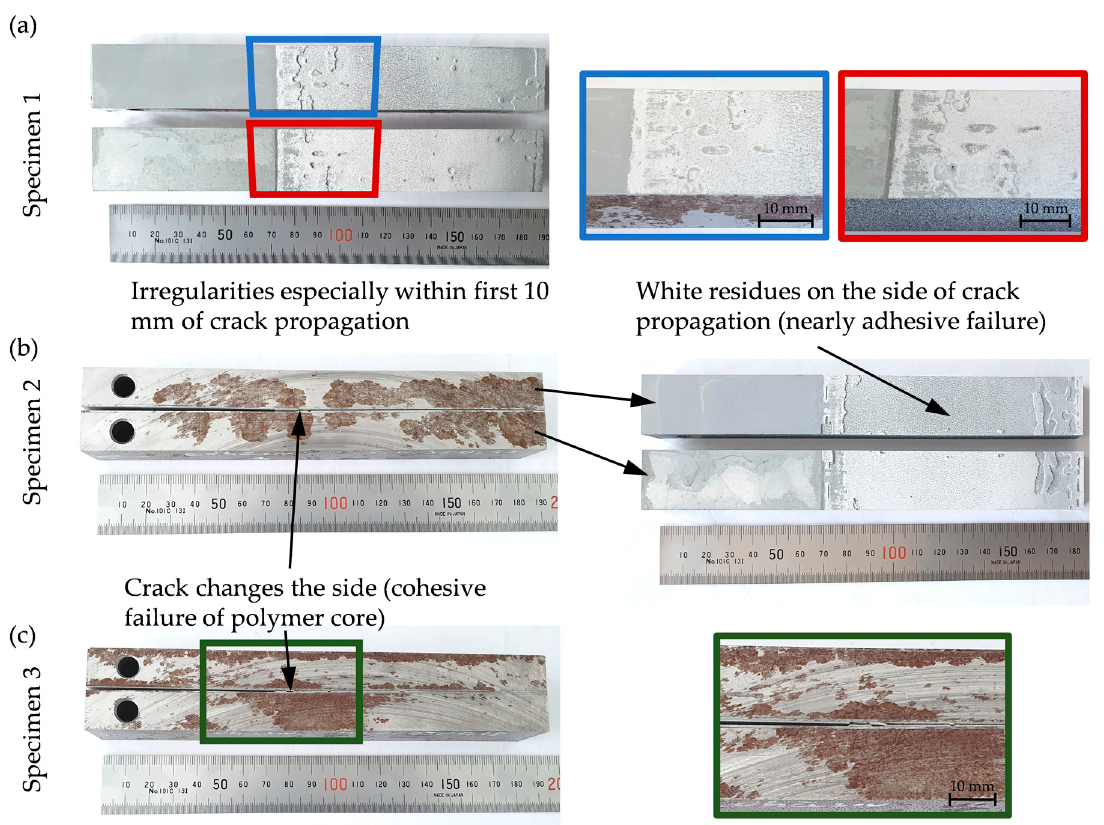
Figure 10. Failure patterns of the metal–polymer-interfaces after DCB-test for: ( a ) specimen 1, ( b ) specimen 2 and ( c ) specimen 3.